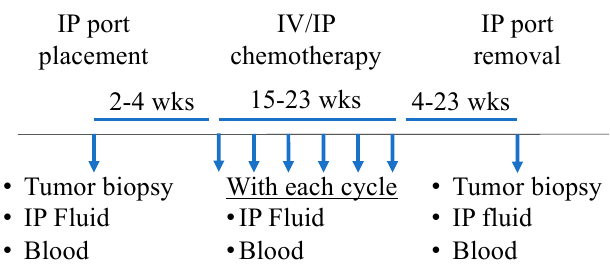
Figure 1. Sample collection schematic.